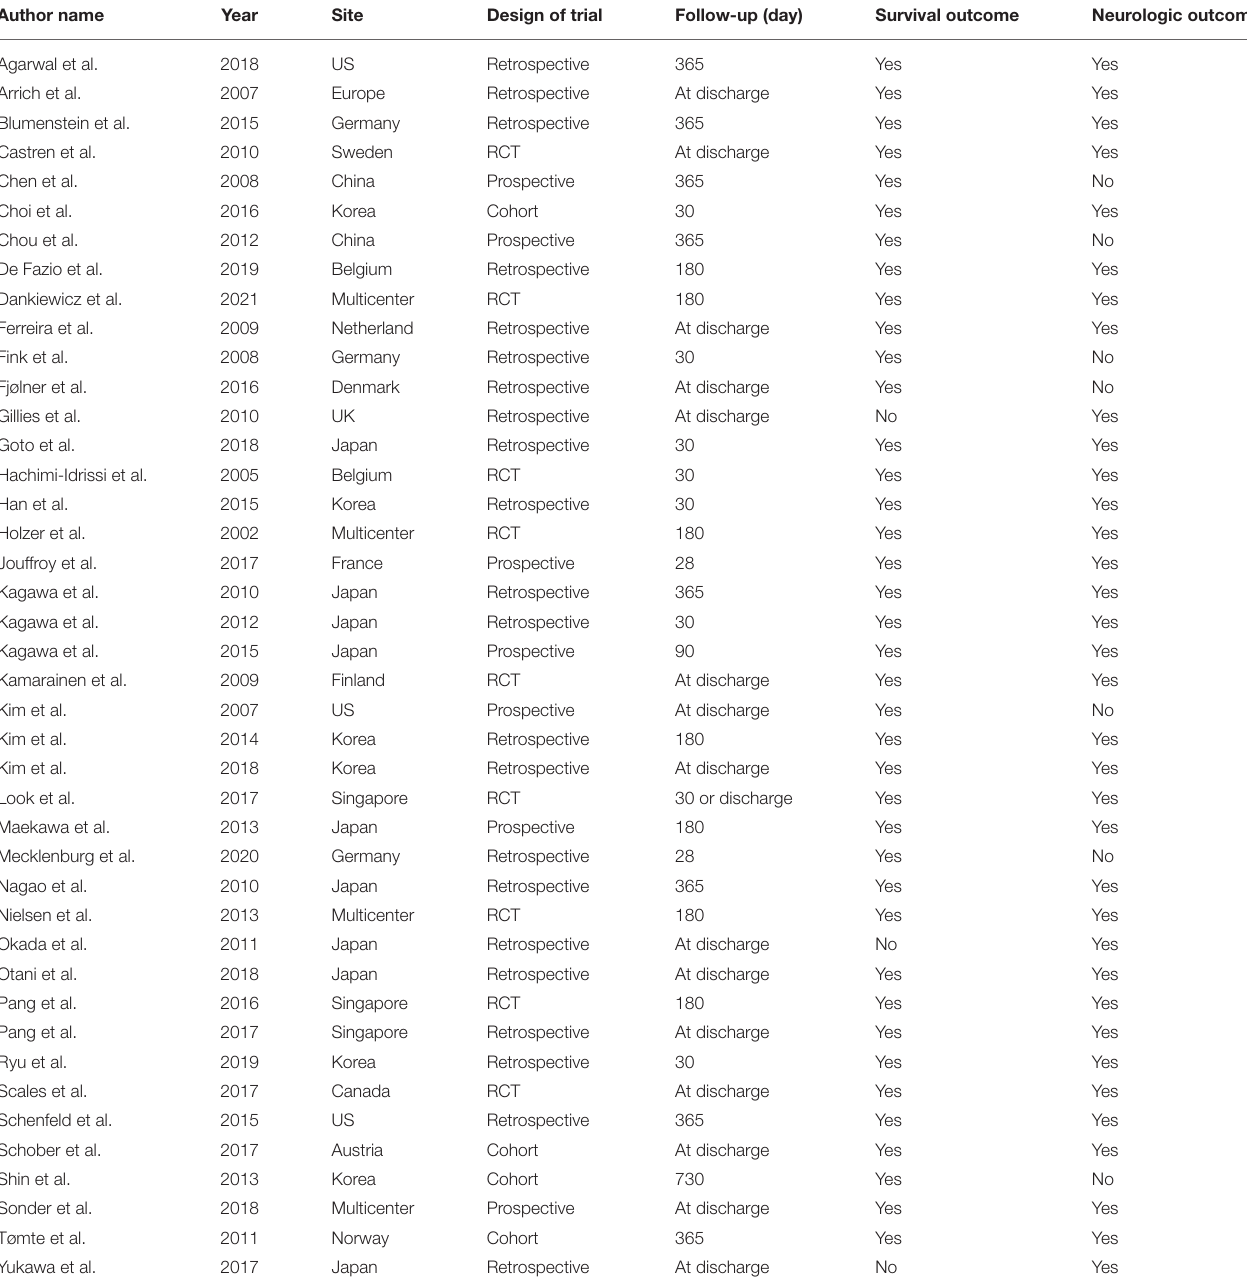
TABLE 1 | Characteristics of included trials (RCT: randomized controlled